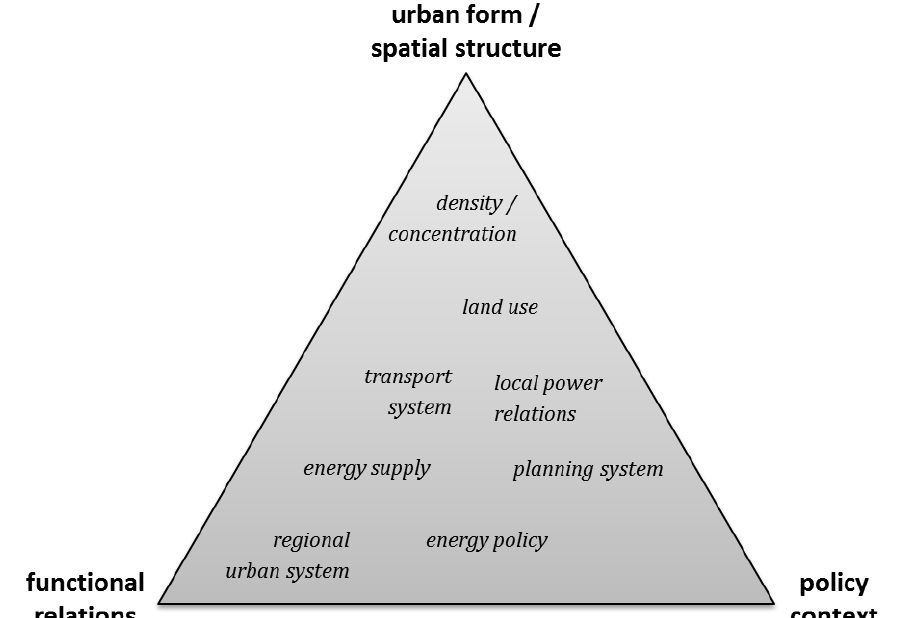
Figure 4. Urban form/spatial structure, functional relations and policy context as interrelated